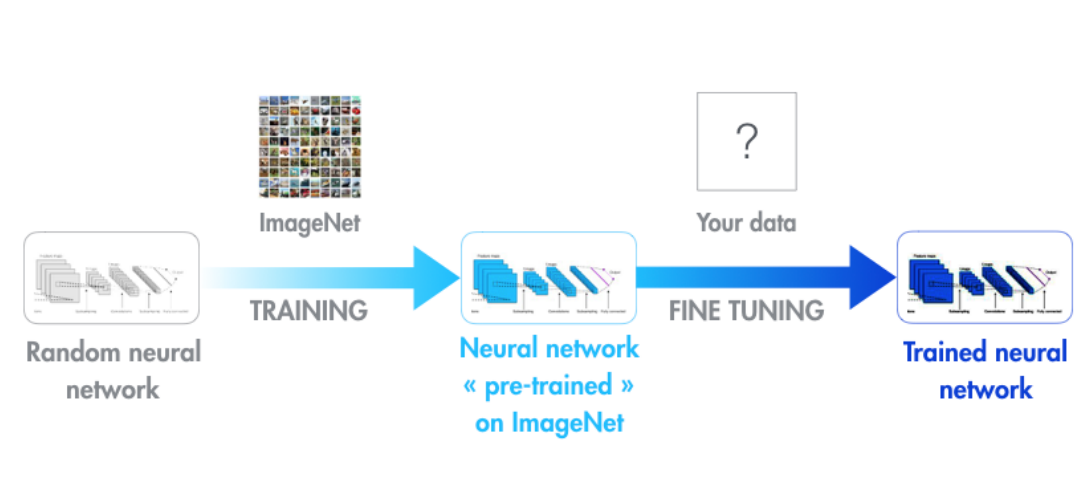
Figure 7. Transfer learning process starting from a random neural network applying pre-trained weights on ImageNet to fine tune on a new dataset